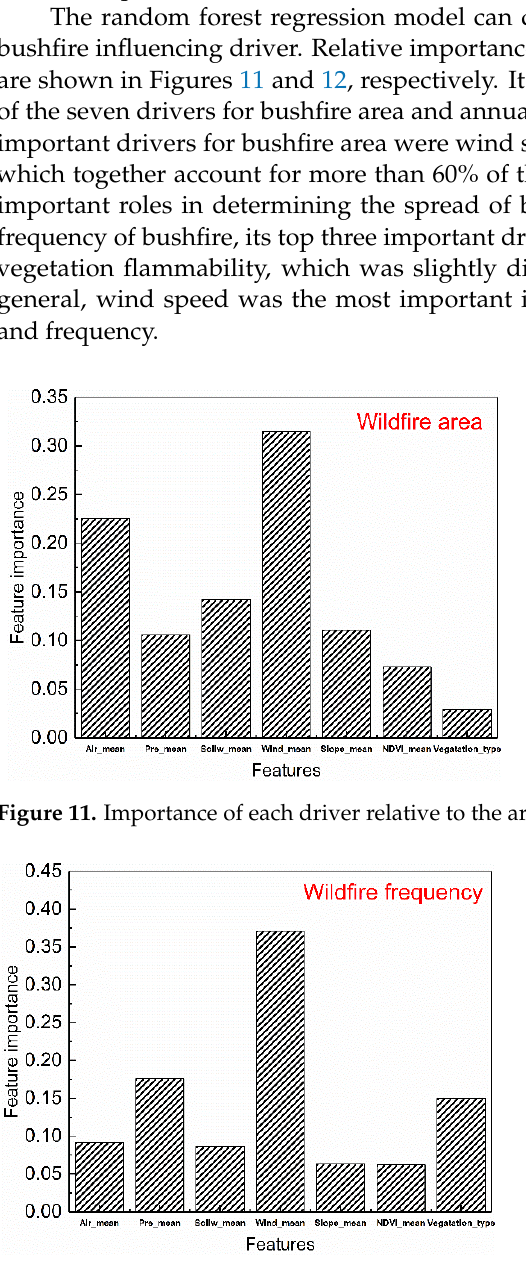
Figure 12. Importance of each driver relative to the annual frequency of bushfire.